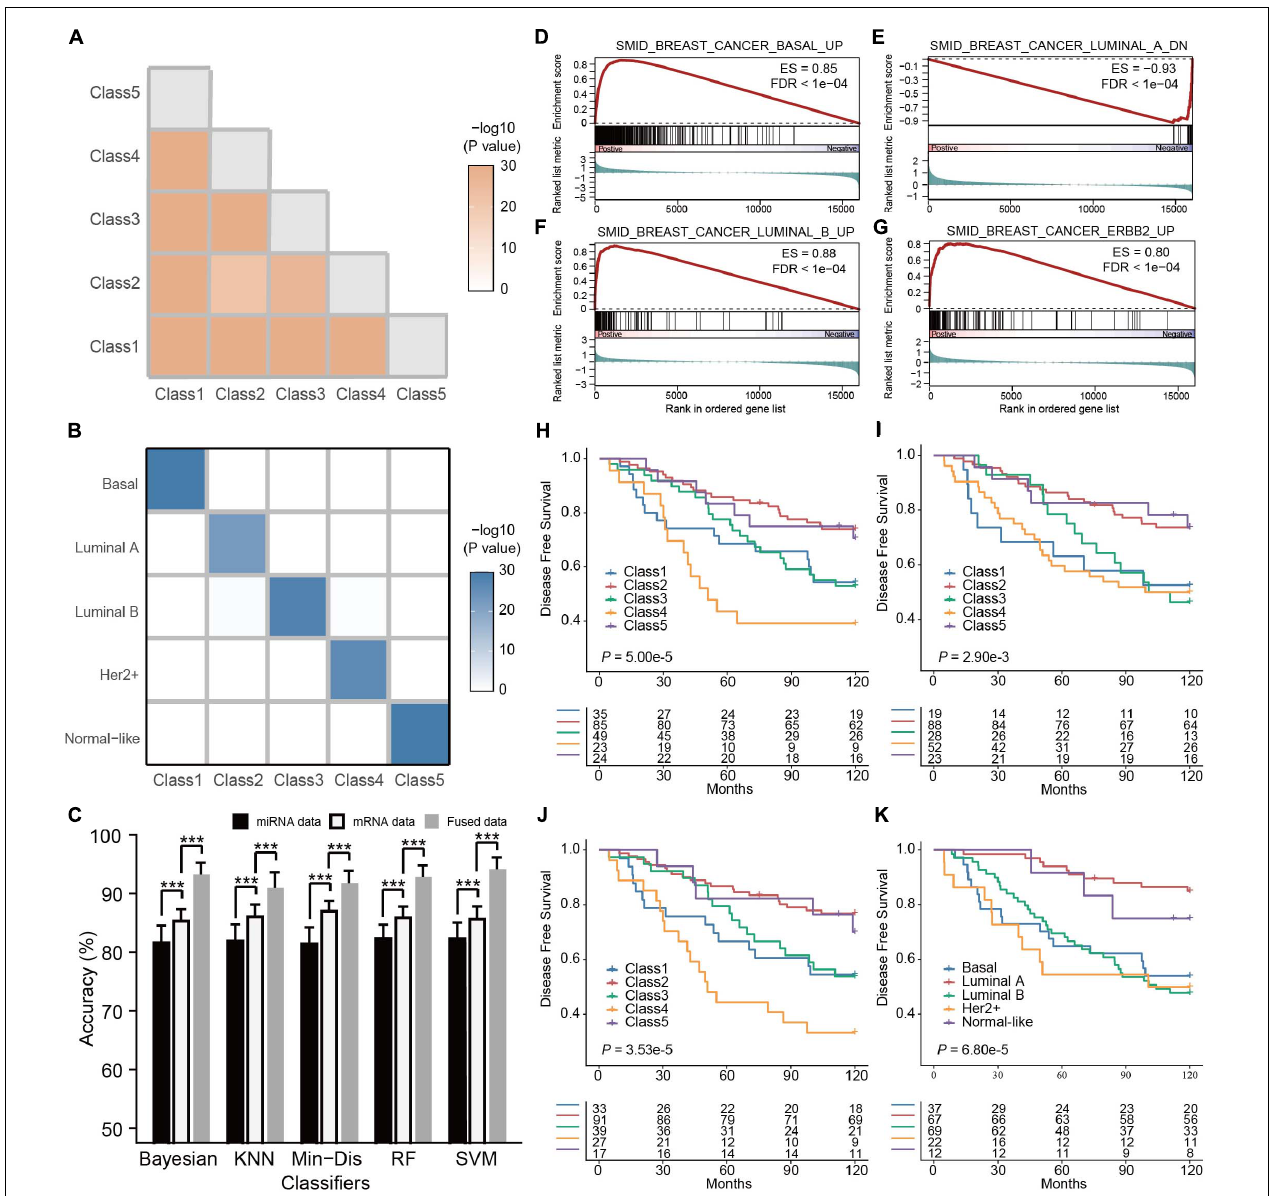
FIGURE 3 | Multi-omics subtyping of breast cancer using sparse canonical correlation analysis for cancer classification (SCCA-CC). (A) A heatmap showing the statistical significance of the differences between the identified breast cancer subtypes. The color depth is proportionate to the -log 10 ( P- values) derived from SigClust. (B) A heatmap illustrating the association between the subtypes identified by SCCA-CC and PAM50. The heatmap is colored in proportion to the -log 10 ( P- values) derived from hypergeometric tests. (C) A bar plot comparing the classification performance of the five classifiers on mRNA data, miRNA data and the fused data, respectively. P- values were calculated based on Wilcoxon signed–rank tests. *** indicates P < 0.001. (D–G) GSEA plots illustrating the representative pathways dysregulated in the Class 1 (Basal-like), Class 2 (Luminal A-like), Class 3 (Luminal B-like), and Class 4 (Her2+-like) subtypes identified by SCCA-CC. (H–J) Kaplan-Meier plots showing the association of the subtypes identified by SCCA-CC using (H) the GSE22219 mRNA dataset, (I) the GSE22216 miRNA dataset and (J) the fused mRNA and miRNA dataset with disease-free survival. (K) Kaplan-Meier plot showing the association of the subtypes identified by PAM50 with disease-free survival. P- values were calculated by log–rank